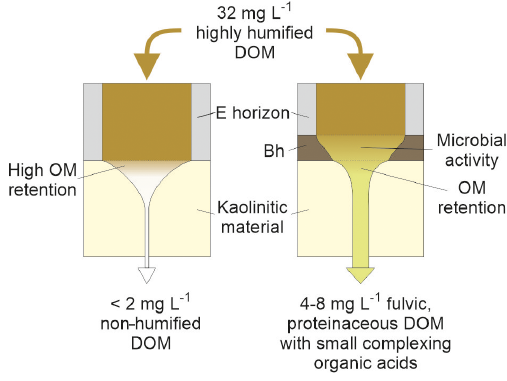
Figure 7. Main conclusions